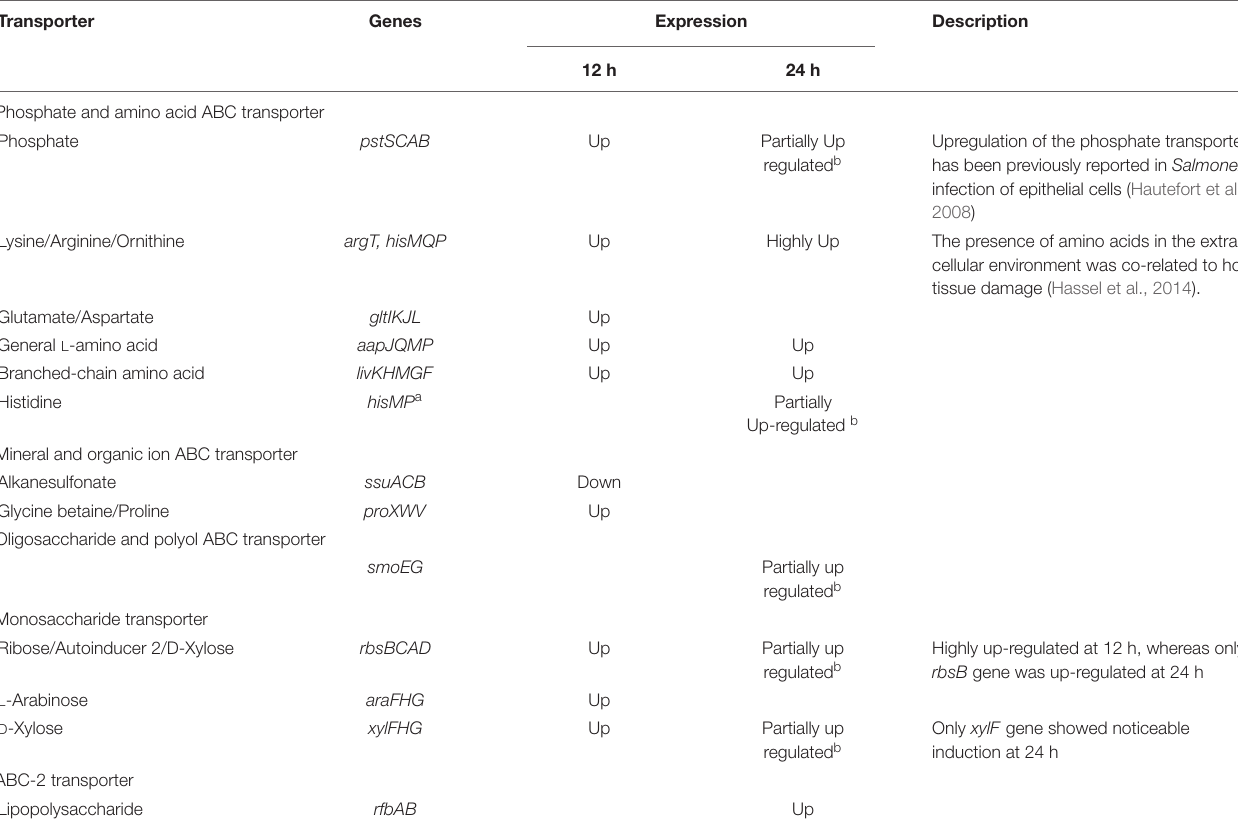
TABLE 3 | Transcriptional profile of ABC transporters during the exponential and the stationary phase